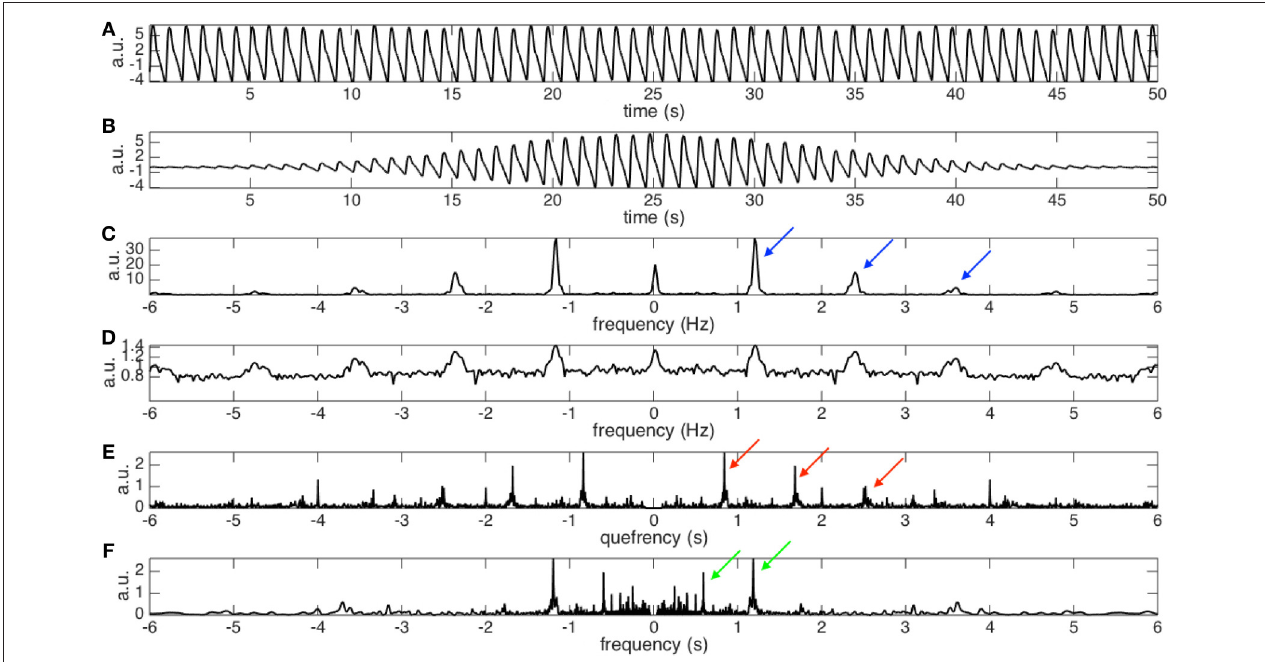
FIGURE 2 | (A) The photoplethysmogram (PPG) signal of the dataset 0031_8 min in the Capnobase database lasting for 50 s. The signal is shifted by 1 to simulate the trend commonly encountered in real data. (B) The “windowed” PPG signal that is generated by multiplying the PPG signal by a Gaussian window centered at the 25-th second. (C) The power spectrum of the windowed PPG signal shown in (B) . The fundamental frequency, 1.2Hz, and its multiples, 1.2 × 2,1.2 × 3, ... , etc, are indicated by the blue arrows. Note that the magnitude varies from peak to peak, which depends on the non-sinusoidal oscillation of the PPG signal. Also note that this power spectrum is the spectrogram at the 25-th second. (D) The 0.1 power of the power spectrum shown in (C) . It is clear that the magnitudes of all peaks become more uniform after taking the fractional power. We could thus view it as a periodic function with the “period” exactly the same as the fundamental frequency of the PPG signal. (E) The spectrum of the (D) that contains the fundamental period information, which is the inverse of the fundamental frequency, of the PPG signal at the 25-th second. Specifically, that the peaks indicated by the red arrows located at 1 / 1.2,2 / 1.2, ... , etc, are associated with the fundamental period and its multiples. (F) The nonlinear mask determined by inverting the quefrency axis by sending a nonzero quefrency q to 1 / q . We could clearly see that the peaks indicated by the red arrows in (E) become the peaks indicated by the green arrows (F) . By a direct algebraic calculation, the peaks indicated by the green arrows correspond to the fundamental frequency, 1.2 Hz, and its divisions, 1.2 / 2,1.2 / 3, ... ,